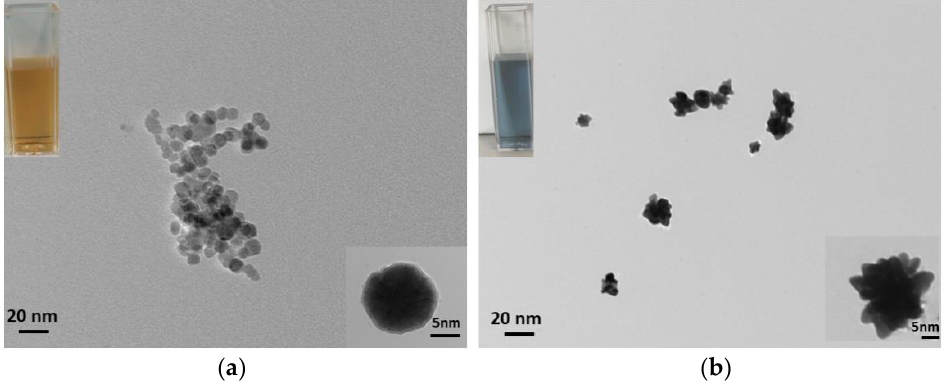
Figure 3. TEM images of ( a ) IONP and ( b ) ICGNP. The insert images on the left top corner illustrate the color of NPs in ultrapure water after synthesis. The insert images at the bottom corner are high magnificent images of individual